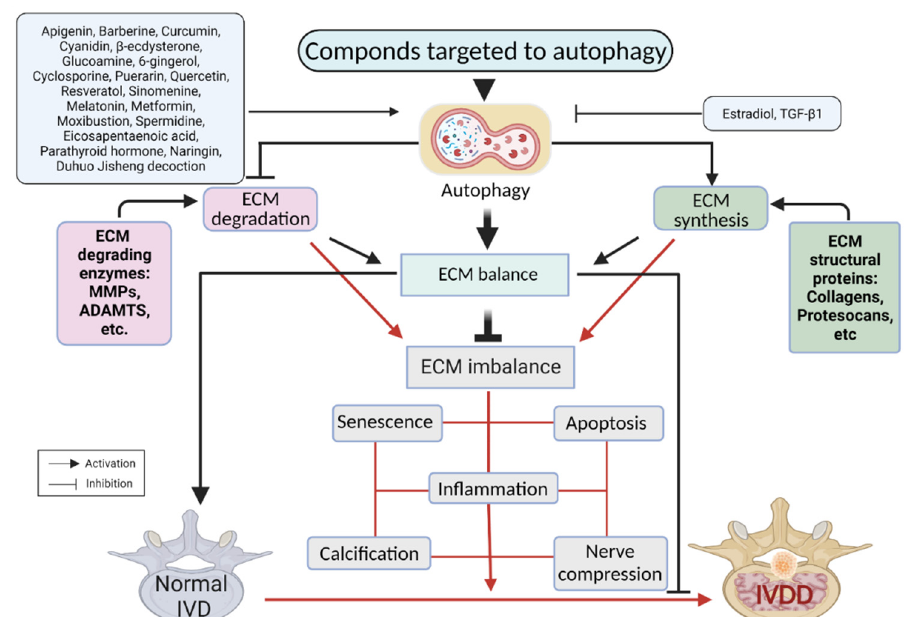
Figure 5. Autophagy-targeting compounds for the treatment of IVDD. Activating compounds (i.e., apigenin) targeting autophagy could reduce IVD cell apoptosis, ECM breakdown, senescence, and CEP inflammation and calcification, thereby balancing levels of IVD ECM components and preventing IVDD. Autophagy inhibiting compounds (i.e., estradiol) reverse this reaction. Black and red lines represent reactions at the balanced or imbalanced ECM condition, respectively.